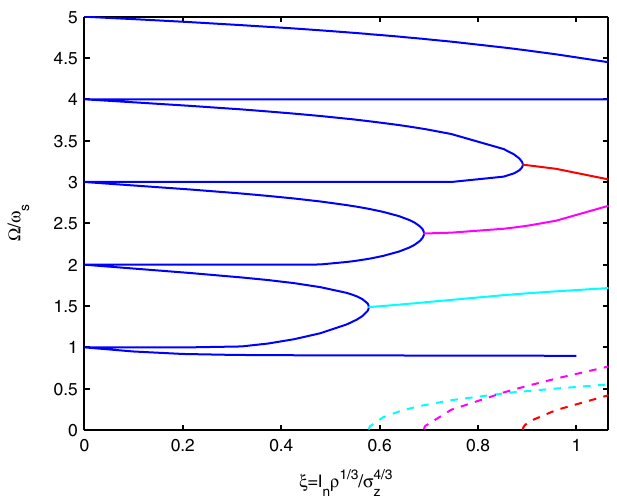
FIG. 5. Mode analysis using the Gaussian model. Solid lines Þ ] and dashed lines represent the coherent tune shifts [ Re ð (cid:2) =! s Þ ] of the unstable modes. For a are for the growth rates [ Im ð (cid:2) =! s given azimuthal mode number, only the radial modes with the largest and smallest tune shifts are